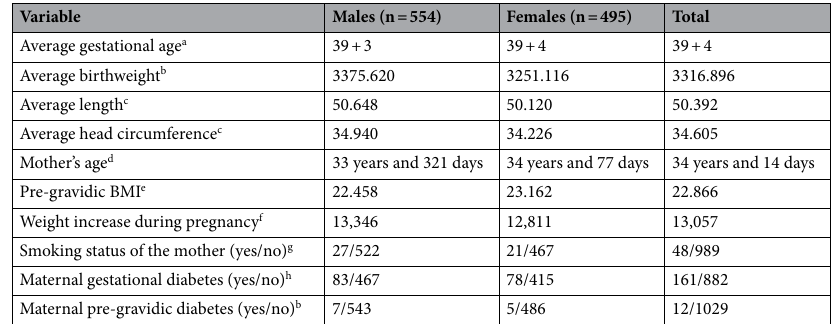
Table 1. Characteristics of the population in study. a This information was available for 1046 subjects. The measurement unit is “weeks”. b This information was available for 1041 subjects. The measurement unit is “g”. c This information was available for 733 subjects. The unit of measure is “cm”. d This information was available for 1029 subjects. The unit of measure is “years”. e This information was available for 731 subjects. The measurement unit is “kg/m 2 ”. f This information was available for 736 subjects. The unit of measure is “g. g This information was available for 1037 subjects; h-This information was available for 1043